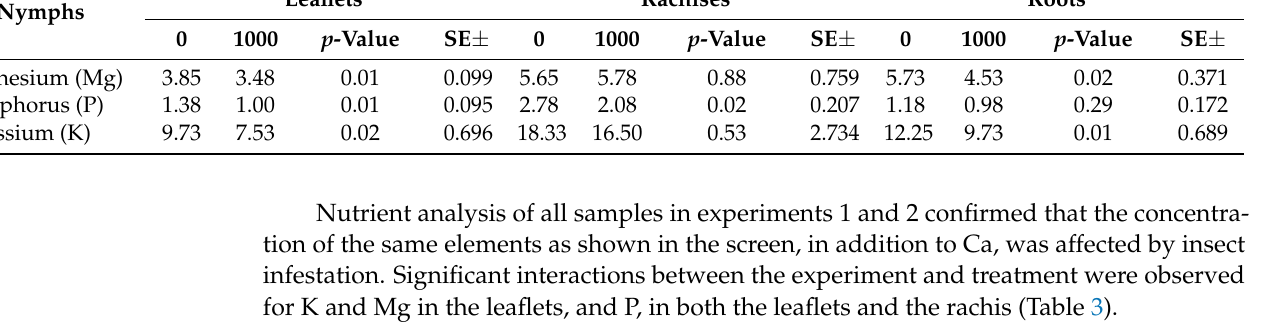
Table 3. Effect of population density of O. lybicus (1st and 2nd instar of nymphs) on the concentration of nutrients in leaflets, rachis and roots of date palms (cv. Khalas). ANOVA and the least significant difference at p < 0.05 were used to compare means between treatments. T = Treatment, E = Experiment. Only significantly different ( p < 0.05) elements between populations are